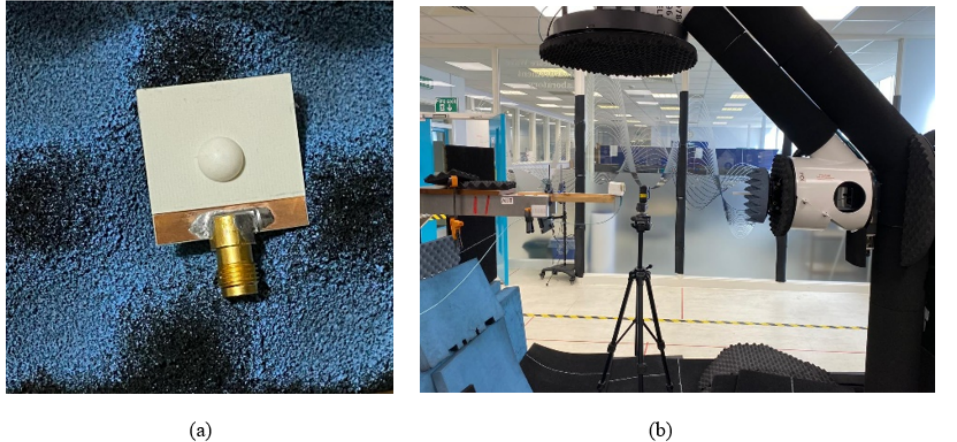
Figure 9. Photographs of ( a ) assembled hemispherical DRA with additional substrate ( b ) DRA in the anechoic